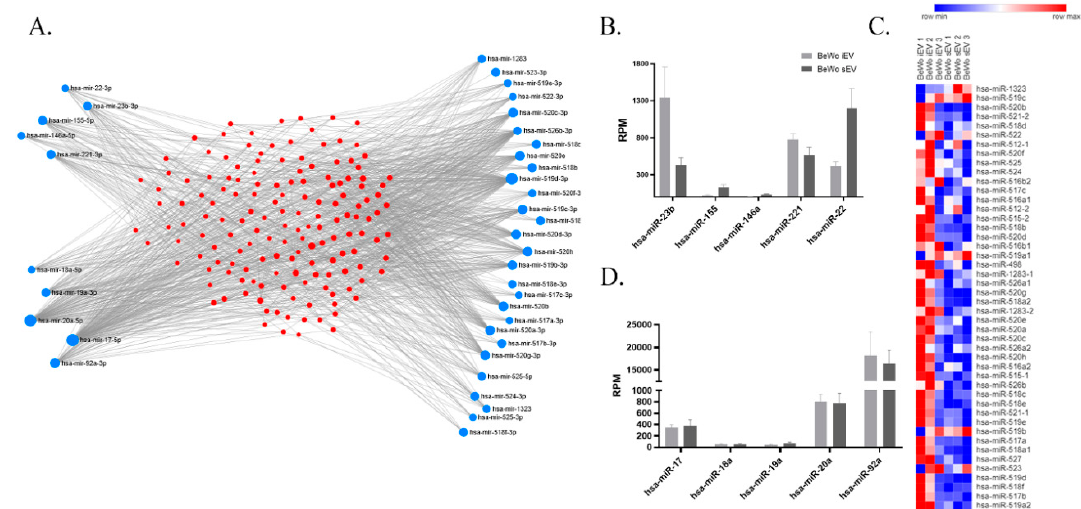
Figure 1. miRNA content of trophoblastic-derived EVs. ( A ) Overview of miRNAs found in trophoblastic (BeWo cells)-derived EVs and their cell di ff erentiation-associated target genes. In the upper left miRNAs involved in the immunological tolerance are displayed. In the lower left, the miR17-92 cluster and, on the right, the placental-specific C19MC cluster are showed. Red dots mark the target genes of the miRNAs. ( B ) Expression of miRNAs involved in immunological tolerance (expression is given in reads per million (RPM), n = 3) ( C ) Expression of miRNAs on the C19MC miRNA cluster, showing that most of the miRNAs are showing a higher expression in the iEV fraction. ( D ) Expression of miR17-92 cluster (expression is given in reads per million (RPM), n = 3).